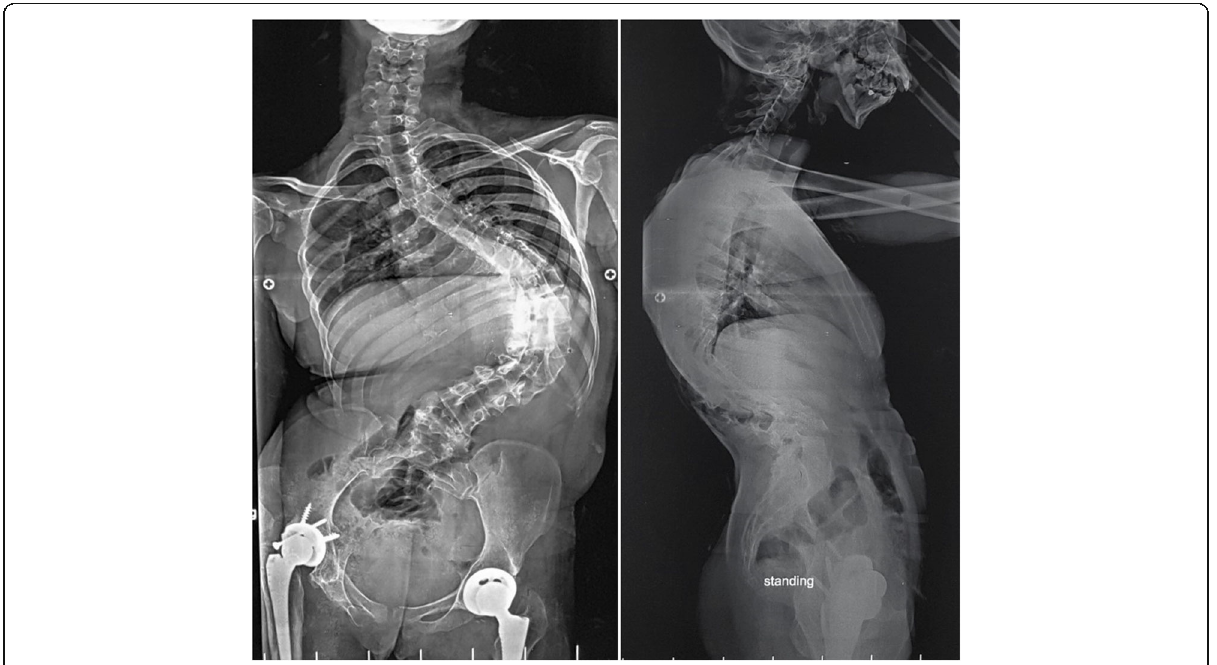
Fig. 3 Final follow-up radiographs of the pelvis and the spine, showing the proper position of the total hip prosthesis, a progression of the spinal deformity, and preservation of the sacroiliac